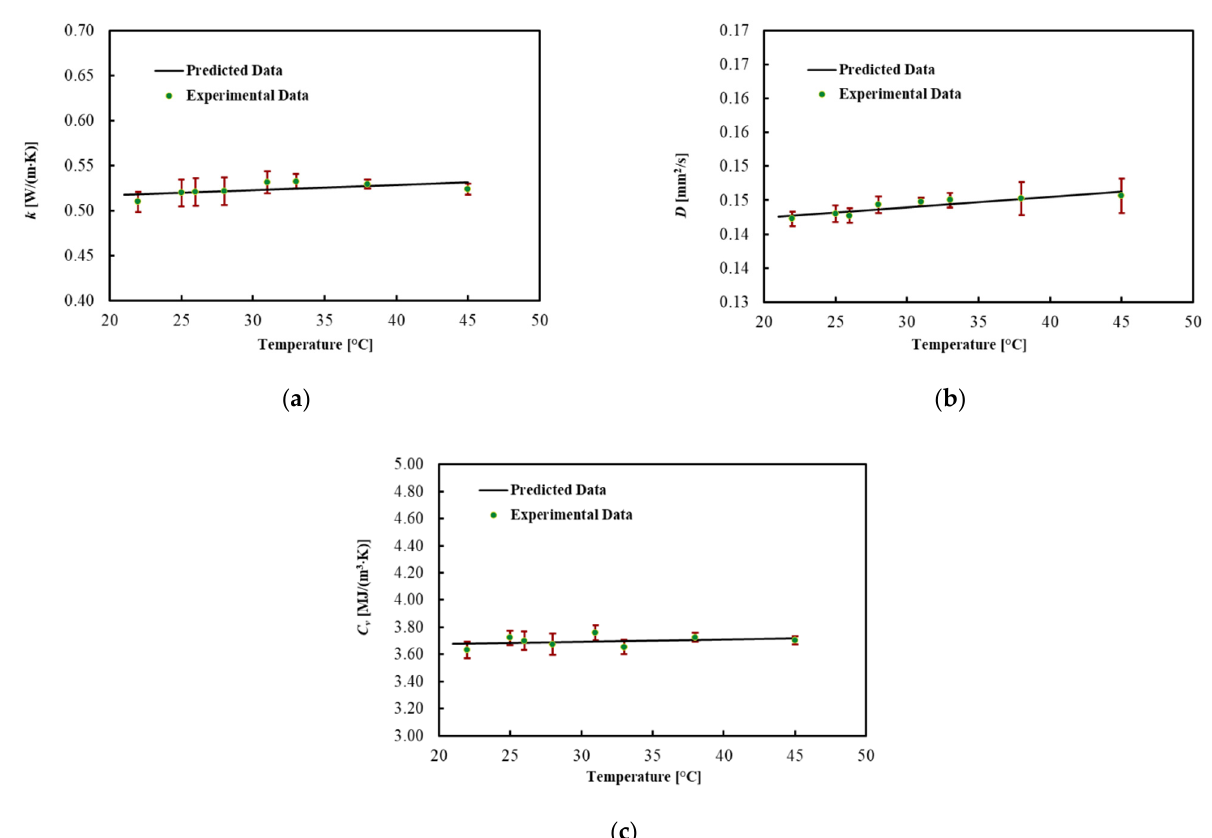
Figure 5. ( a ) Thermal conductivity, ( b ) thermal diffusivity and ( c ) volumetric heat capacity for ex vivo porcine pancreases